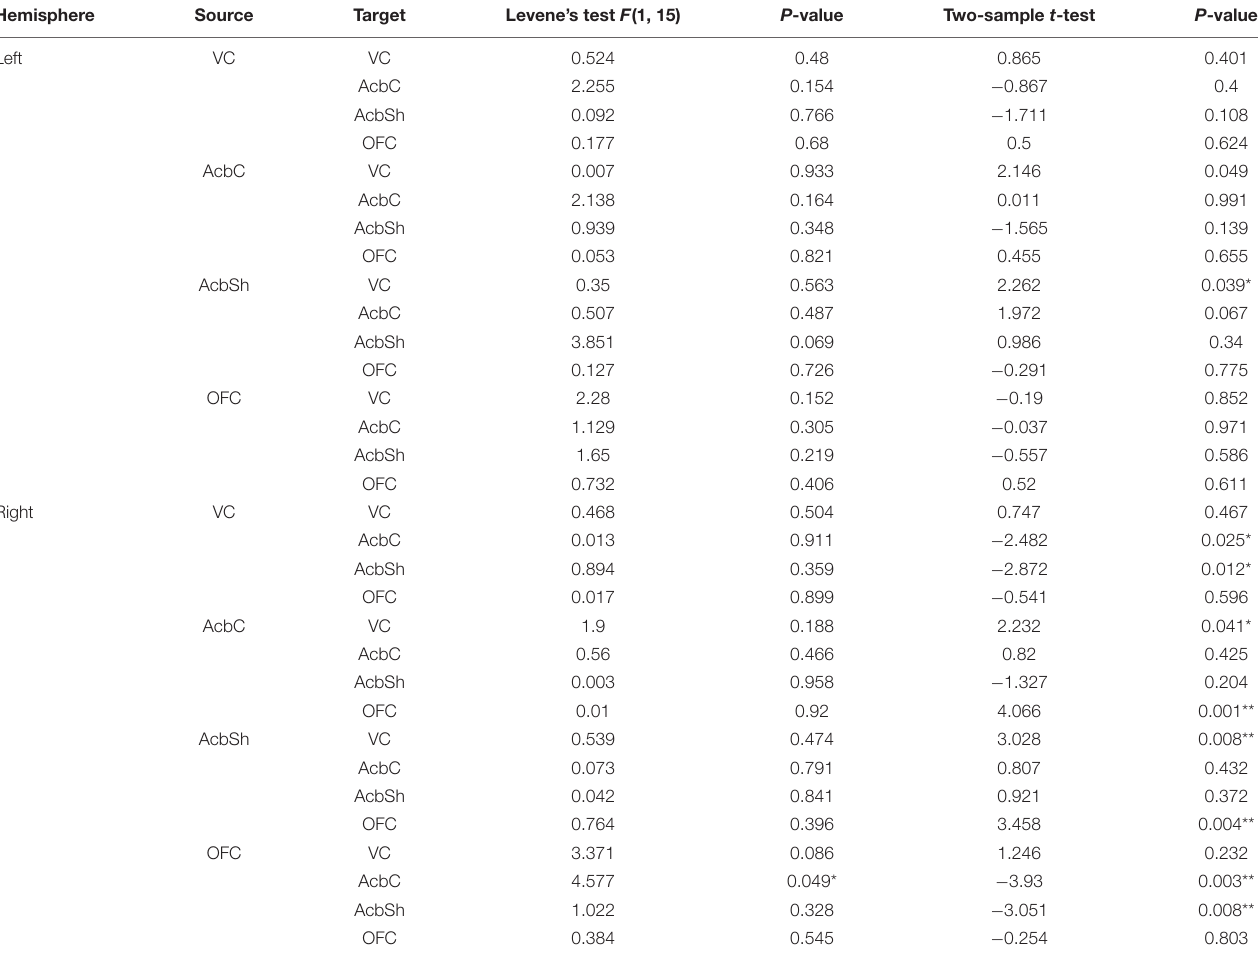
TABLE 3 | Comparisons of EC between MAM-rTMS and vehicle-rTMS groups. Hemisphere Source Target Levene’s test F (1, 15) P